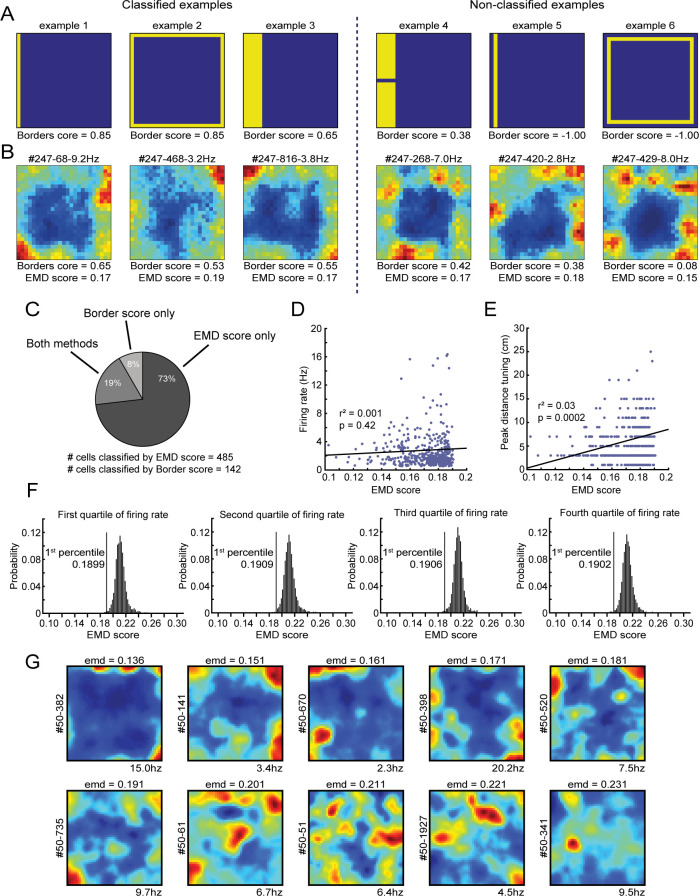
Comparison between the EMD metric and original border score and its relationship with a cell’s firing rate.(A) Shown are six examples of simulated rate maps and their associated border scores. This metric is designed to capture the coverage of a firing field alongside a single wall, and a maximal score is reached when it occupies only bins that are directly connected to the wall (ex. 1). On the left: three simulated examples of rate maps that would be classified as border cells. On the right: three examples of non-classified rate maps. Extension of a field toward the center lowers the border score (ex. 3), as does breaking the field into two or more subfields (ex. 4). The algorithm is unable to calculate a border score when the firing field does not directly touch the boundary (ex. 5). The border score furthermore does not consider symmetry, as the maximum score on any of the four walls is selected (ex. 2 and 6). (B) Shown on the left are three example RSC border cells that were classified correctly by both the border score (values above 0.5) and our EMD template matching method (values below 0.1906). By contrast, on the right are shown three qualitatively similar RSC border cells that were identified only by the EMD method, as these cells had low, non-significant border scores. RSC border cells tend to form firing fields that are not necessarily connected to the wall, and are often not continuous due to additional directional tuning, leading to low border scores. (C) Distribution and overlap of border cell classification using the border score and EMD methods. (D) No significant correlation exists between a cell’s firing rate and its EMD score. (E) A small correlation (r = 0.17) exists between a border cell’s EMD score and its preferred firing distance, as cells with lower distance tuning are more similar to the boundary template. (F) Four EMD spike-shuffled null distributions, same as in Figure 1E, using rate maps of cells with overall firing rates that fall in one of four quartiles of the total population of neurons. The EMD template matching procedure is robust against differences in the overall spiking rates, where the significant criterion remains at the same cut-off independent of the firing rate of the underlying population of cells included. (G) Spatial rate maps of neurons recorded in RSC of one individual animal with EMD scores at evenly spaced intervals (range: 0.14–0.23). Cells with a score below the value of 0.191 are considered to be border cells.